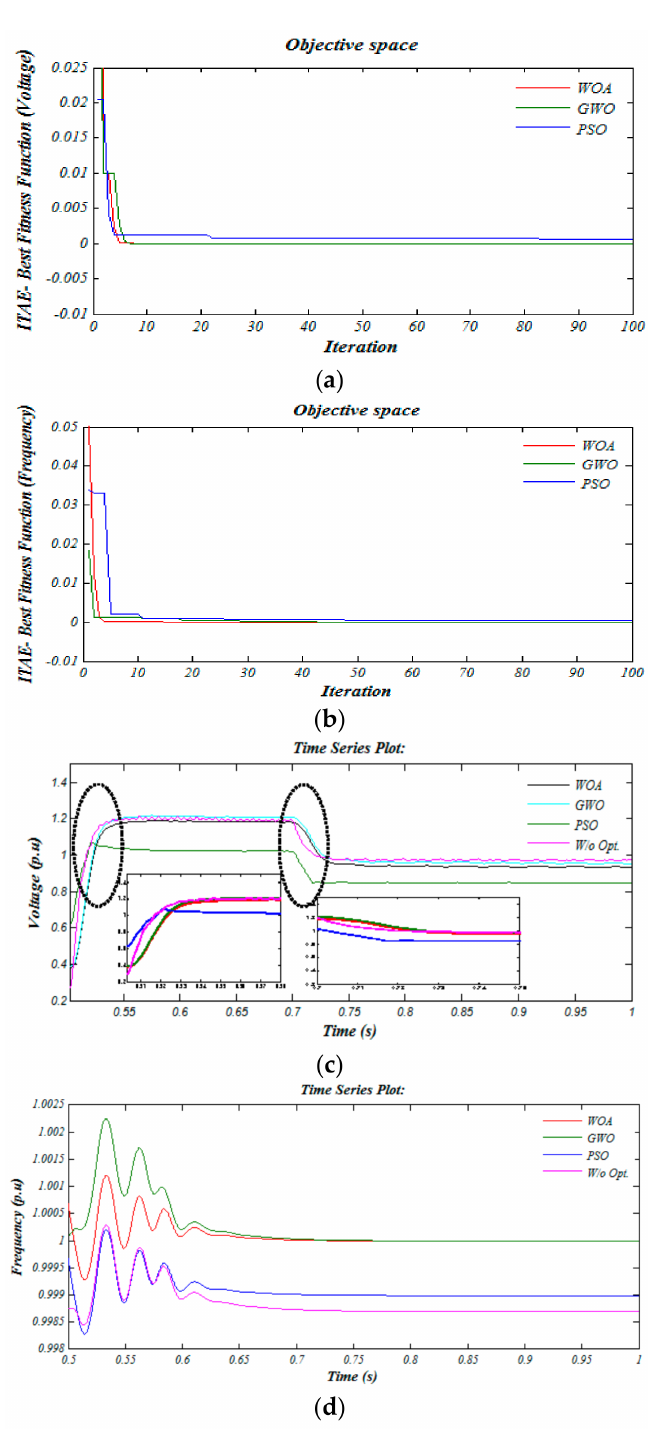
Figure 9. Simulation results during load changing. ( a ) Best Fitness Function for Voltage; ( b ) Best Fitness Function for Frequency; ( c ) System Voltage Parameter; ( d ) System Frequency